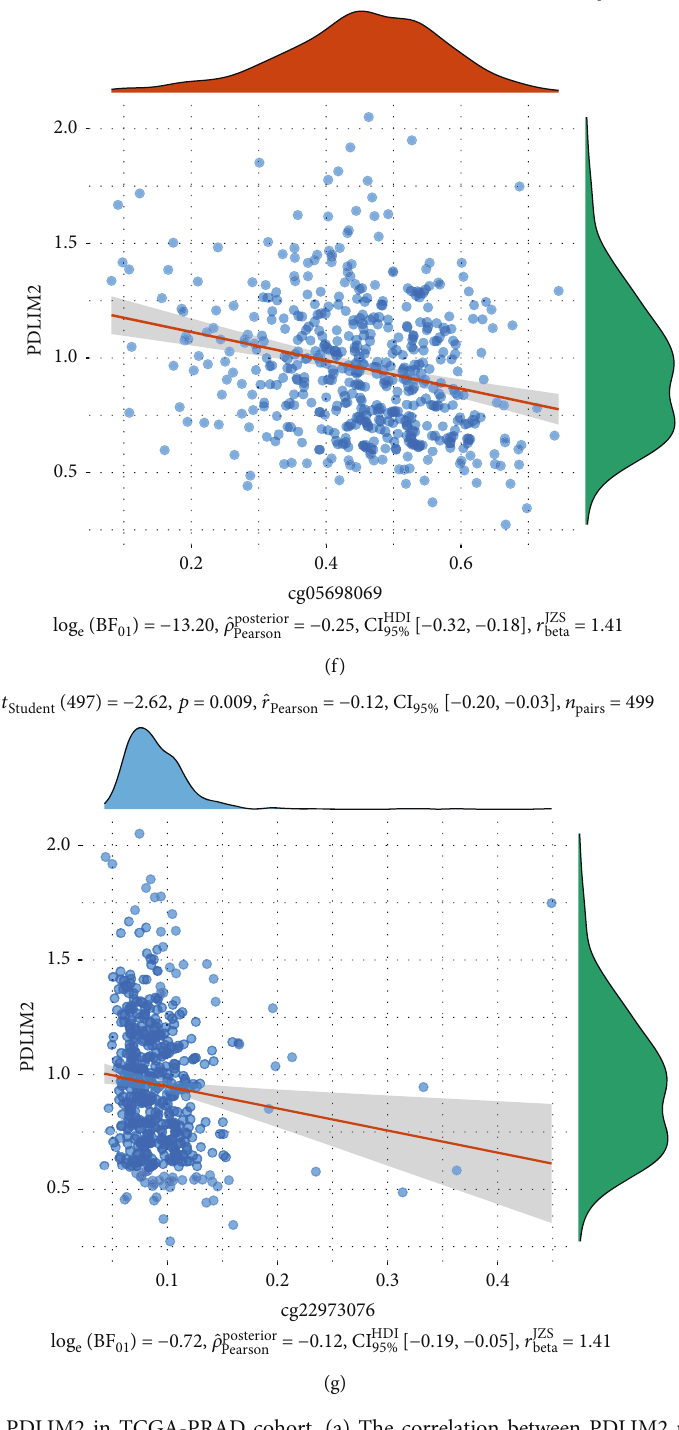
Figure 4: DNA methylation of PDLIM2 in TCGA-PRAD cohort. (a) The correlation between PDLIM2 methylation sites and PDLIM2 expression in patients with prostate cancer. Blue represents a negative correlation; red represents a positive correlation; “ × ” represents no statistical signi fi cance. (b) Kaplan – Meier survival analysis showed that the cg22973076 methylation site in PDLIM2 was correlated with poor PFI in prostate cancer patients ( P < 0 : 05 ). (c – g) Spearman ’ s correlation analysis showed a correlation between the PDLIM2 mRNA expression level and PDLIM2 methylation sites in prostate cancer